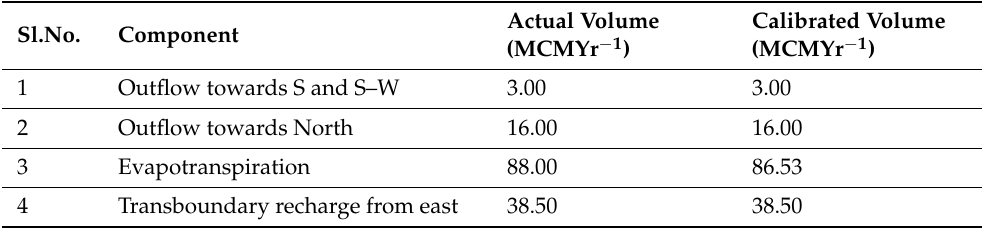
Table 3. Comparison of reported and simulated water budget components in the year 2017 [25,43].